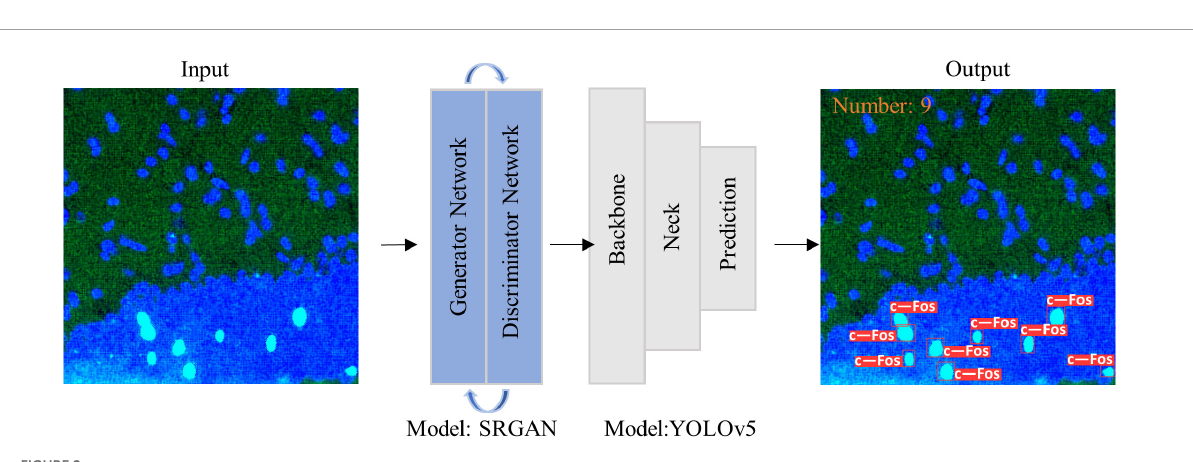
FIGURE2 Diagram of model structure. Images were imported into super-resolution generative adversarial network (SRGAN) model, and then the enlarged image was inputted to you-only-look-once-v5 (YOLOv5) model to obtain visualization results as